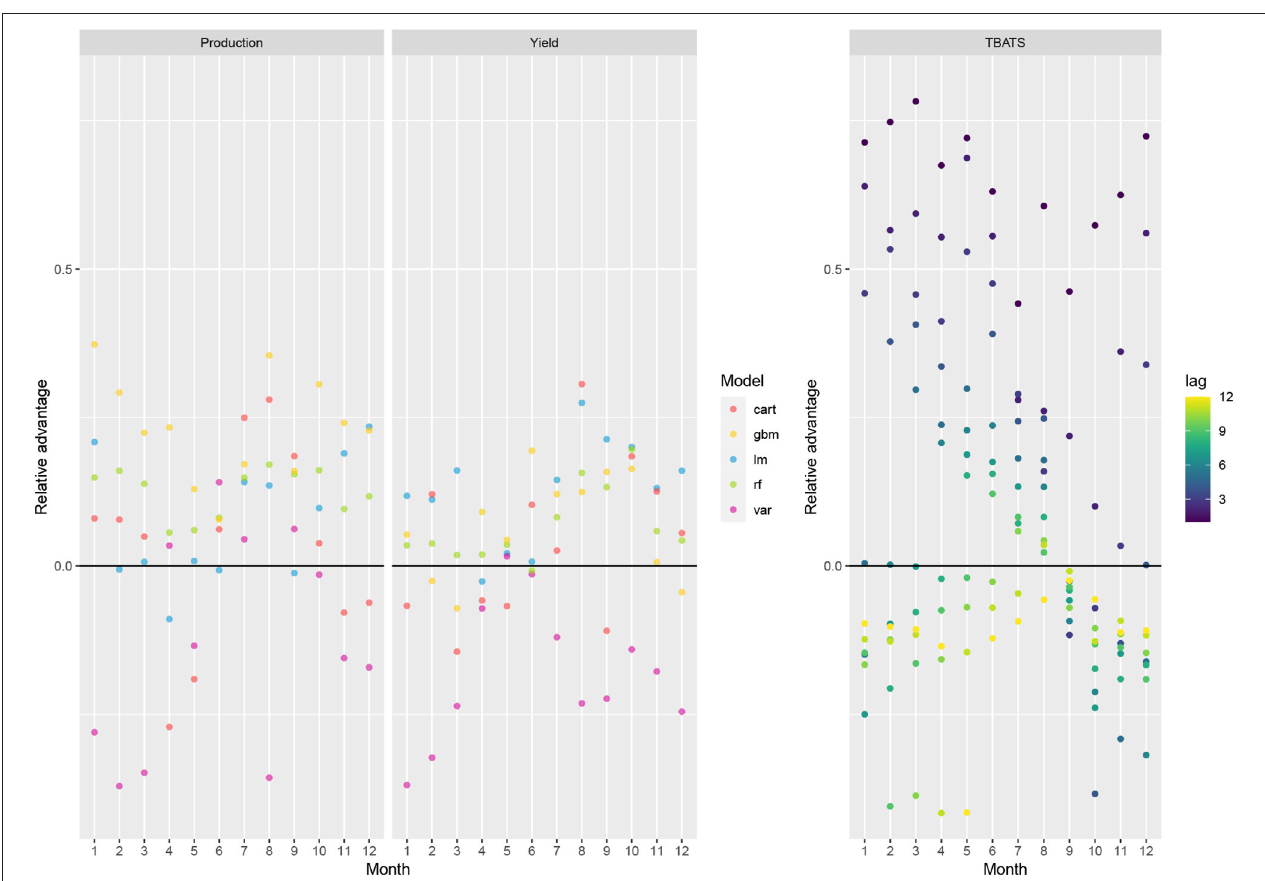
FIGURE 3 | Relative advantage in terms of prediction accuracy of the forecasting models, over 1990–2020. This measure corresponds to the difference between the standard deviation of the price changes in the whole dataset ( sd ( p m , y )) and the RMSE of each model the same month, divided by sd ( p m , y ), and expressed in percentages. It indicates the relative benefit of using the models compared to a constant prediction equal to zero. ML methods, LM and VAR were used with production and yield inputs,